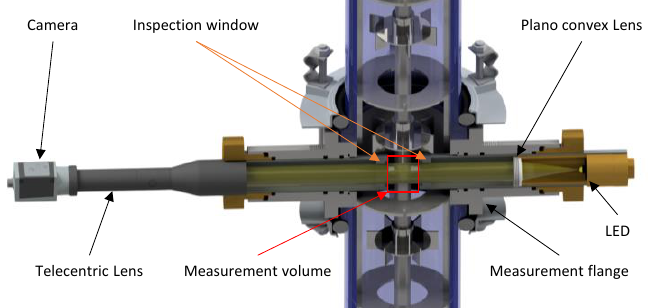
Figure 1. Scheme of a OMOP in a DN100 extraction column. The invasive tubes are mounted eccentric and do not interfere with the impeller shaft.